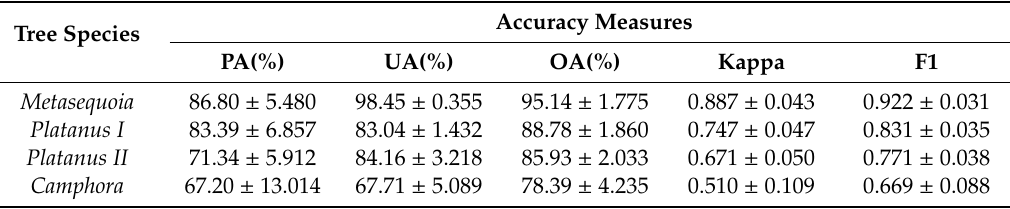
Table 4. Mapping accuracies of four tree species using the comparative